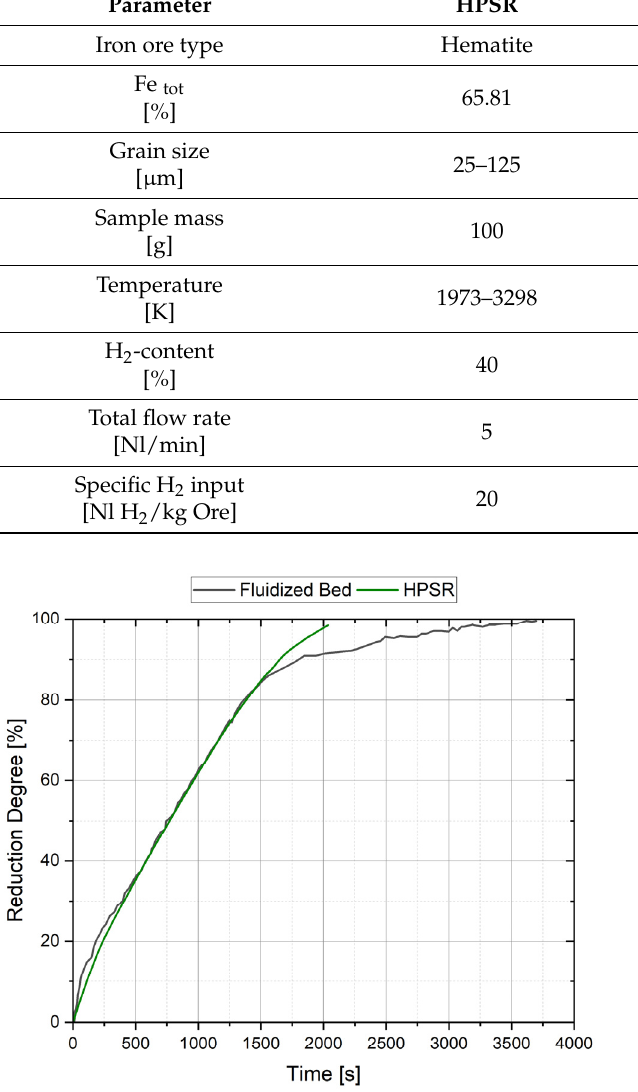
Figure 8. Reduction degree over time for both technologies.